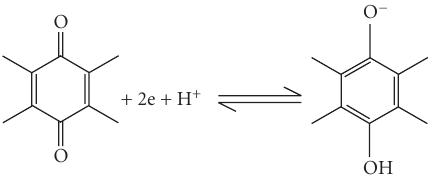
Scheme 5: Two-electron one-proton reduction of quinone in aqueous bu ff